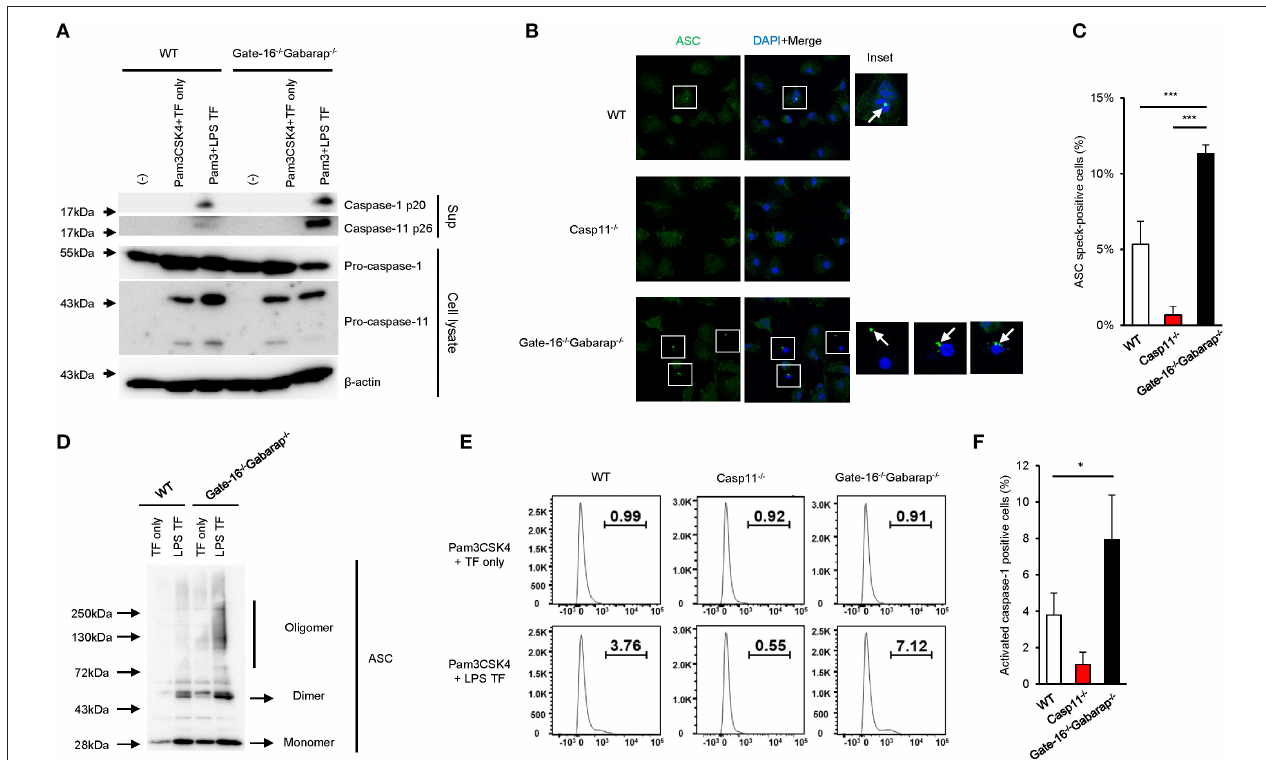
FIGURE 2 | Enhanced caspase-11-mediated signaling pathways in Gate-16 − / − Gabarap − / − macrophages. (A) Western blot analysis of cleaved caspase-1 (p20) and caspase-11 (p26) in cell supernatants, and of pro-caspase-1 and pro-caspase-11 and Actin (loading control) in cell extracts of wild-type (WT) and Gate-16 − / − Gabarap − / − BMDMs primed with Pam3CSK4 followed by LPS transfection for 16h. (B) Fluorescence confocal microscopy of wild-type (WT), Casp11 − / − , and Gate-16 − / − Gabarap − / − BMDMs primed with Pam3CSK4 followed by transfection of LPS for 6h and immunostained for ASC (green). The nucleus was stained with DAPI (blue). Squares show cells with ASC speck. Arrow indicates ASC speck itself. Scale bars correspond to 20 µ m. (C) Percentage of ASC speck-positive wild-type (WT), Casp11 − / − and Gate-16 − / − Gabarap − / − BMDMs, as quantified by counting at least 100 cells per coverslip by confocal microscopy. (D) Oligomerization assay of ASC in cell extracts of wild-type (WT) and Gate-16 − / − Gabarap − / − BMDMs primed with Pam3CSK4 followed by LPS transfection for 6h was analyzed by western blot. (E,F) Caspase-1 Pam3CSK4 primed wild-type (WT), Casp11 − / − and Gate-16 − / − Gabarap − / − BMDMs BMDMs were transfected with LPS for 4h and added with FAM-FLICA to detect activated caspase-1 by flow cytometry (E) or by analysis for the quantification (F) . The data are representative of three independent experiments (A,C,E) and are combined data of more than three independent experiments (C,F) . * P < 0.05, *** P < 0.001, two-tailed t